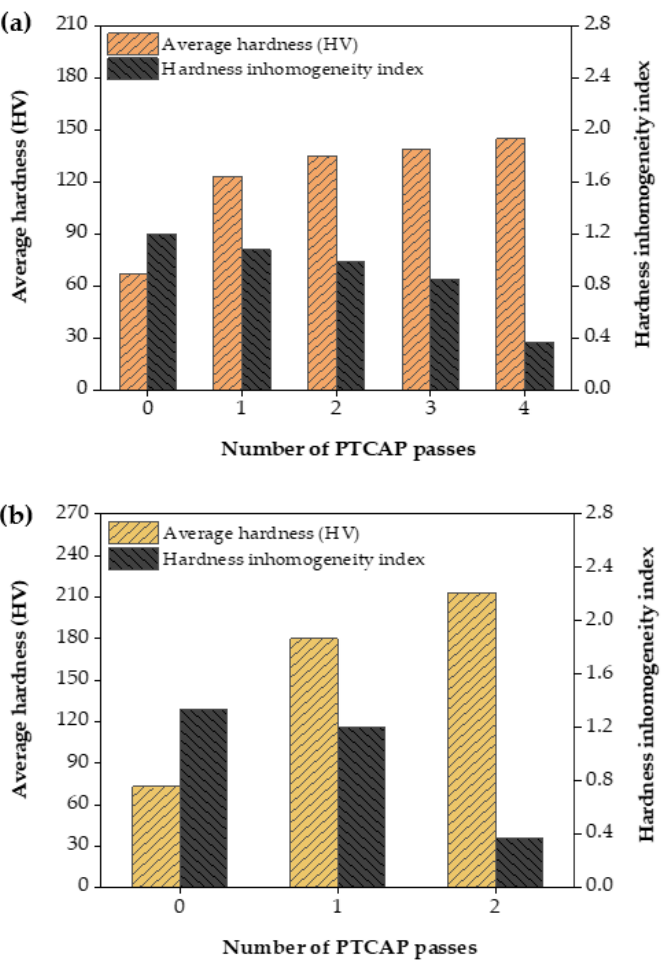
Figure 6. Average hardness and hardness inhomogeneity index before and after PTCAP passes in ( a ) copper and ( b ) brass alloy tubes. ( a ) copper and ( b ) brass alloy